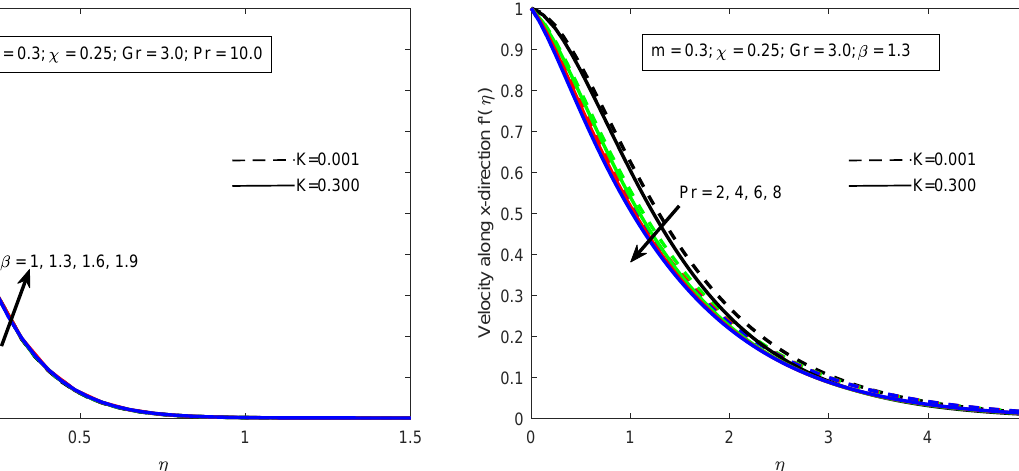
Figure 14: Variation of temperature profile with Casson fluid parame-